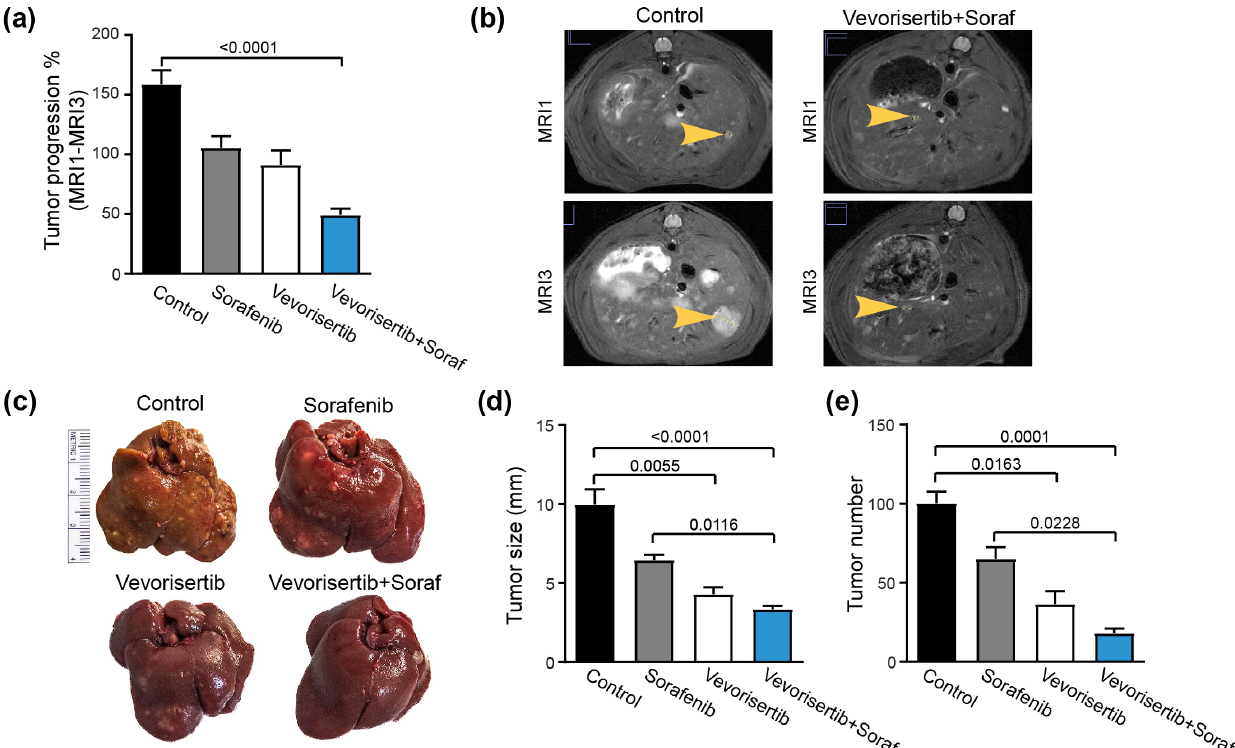
Figure 2. Effect of vevorisertib and vevorisertib + sorafenib treatment on tumor progression. ( a ) Tumor progression assessment calculated as tumor size (MRI3–MRI1)/MRI1 and ( b ) representative images of abdominal MRI1 and MRI3 scans of control and vevorisertib + sorafenib treated rats. ( c ) Representative images of liver of control, sorafenib, vevorisertib and vevorisertib + sorafenib treated group. ( d ) Macroscopic examination of livers with an assessment of tumor size calculated as average diameter of the five largest tumors. ( e ) Macroscopic examination of tumor number at the surface of the livers. n = 7/group, values are mean ± SE. Kruskal–Wallis test was used for multiple comparisons.